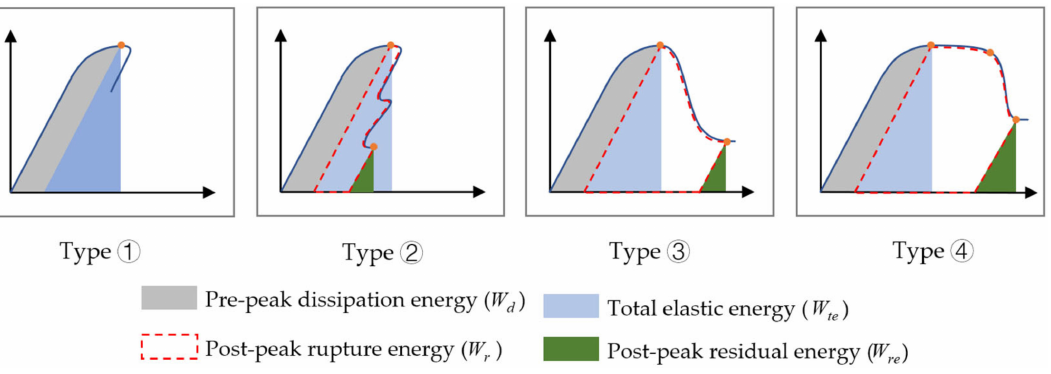
Figure 8. Energy distribution of different stress–strain